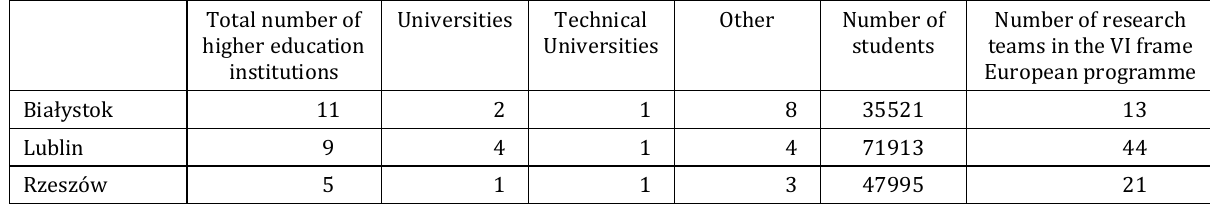
Table 5. Schools of higher education in Białystok, Lublin and Rzeszów